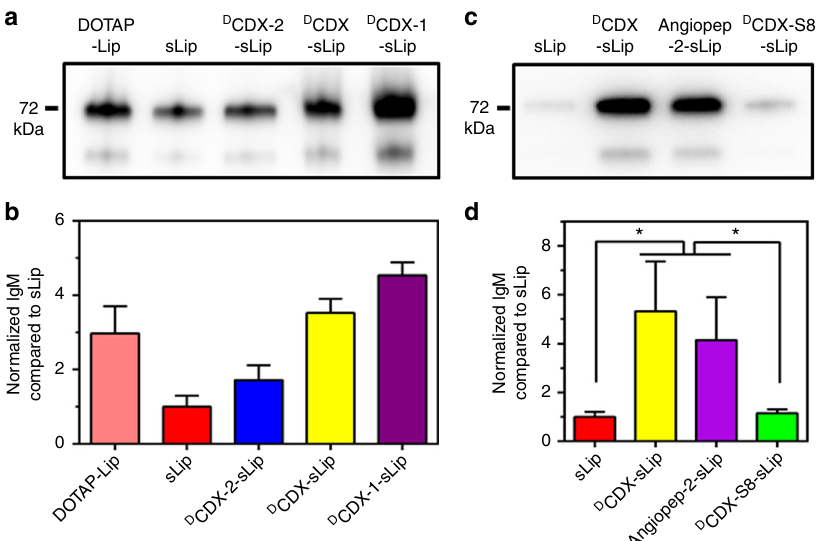
Fig. 5 Effect of electrostatic interaction on the absorption of natural IgM. a , c Western blot assay of natural IgM on liposomal surface after incubation with serum for 1 h. b , d Quanti fi cation of absorbed natural IgM by normalizing gray values. n = 3, data are means± s.d. Statistical signi fi cances were calculated by Student ’ s t -test. * p <